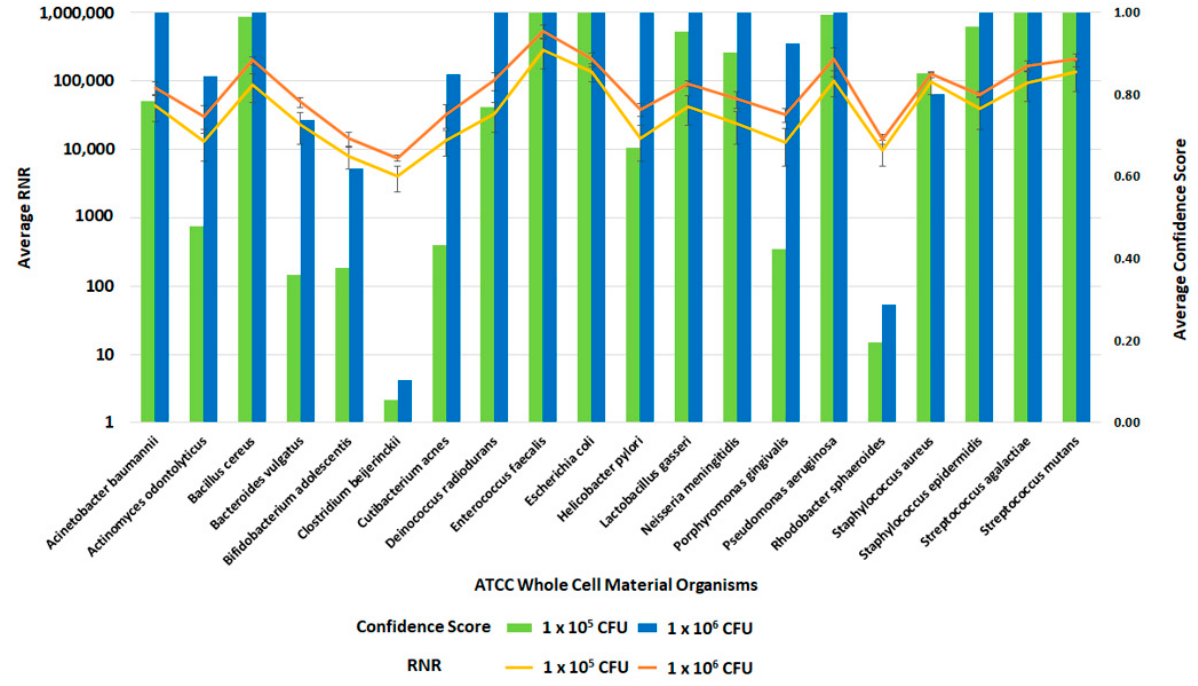
Figure 13. Inclusivity of ATCC Whole Cell Material Microbiome Standard—RBM Swabs. This figure summarizes the average RNR and Confidence Scores based on 4 of 4 contrived, RBM swab replicate samples. Bars represent sample confidence scores, and lines represent sample RNR